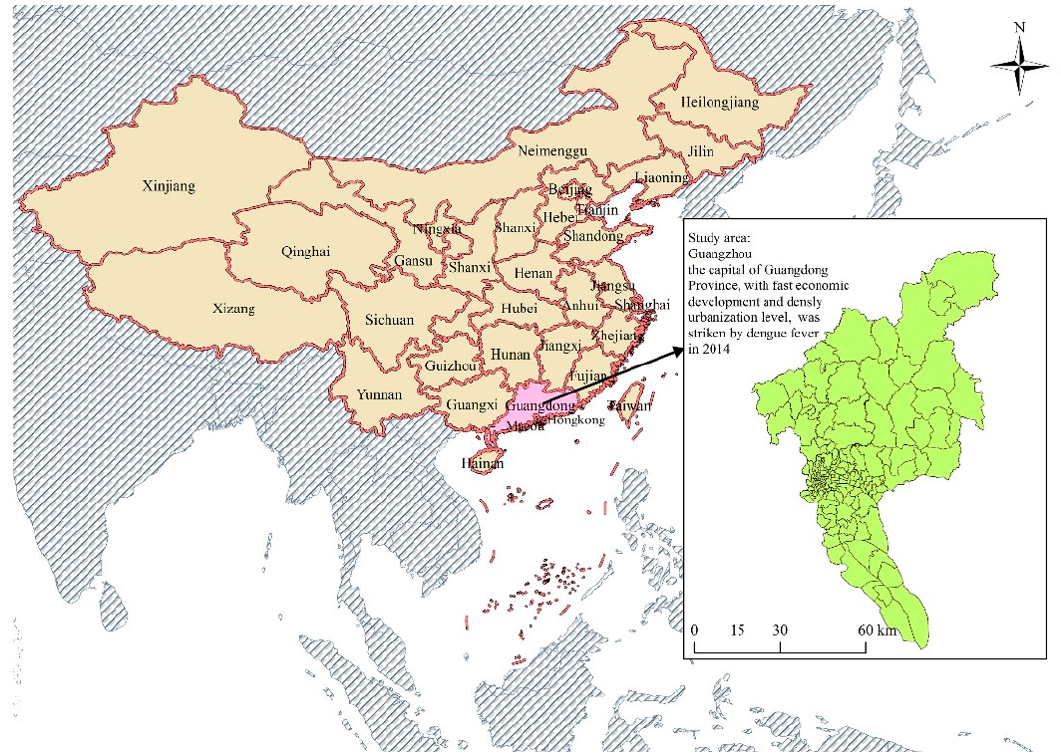
Figure 1. Geographical location of townships/street in the study area of Guangzhou, Guangdong, China.